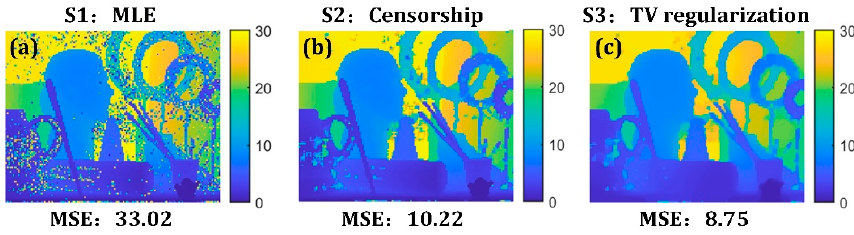
Figure 4. FSPU reconstruction steps; on average, 2700 pulses per pixel (ppp) were emitted with 67.8 counts per pixel (cpp), 89% of which, however, were noise counts. ( a ) Step1: Maximum likelihood estimation, ( b ) Step2: anomaly censorship, ( c ) Step3: TV regularization.